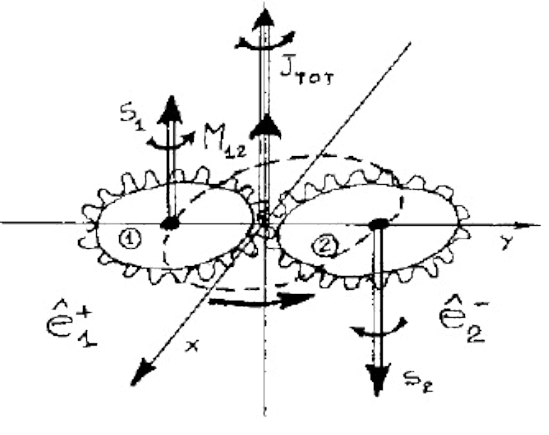
Figure 5: A reproduction of “gear model“ used in Section 5, page 852, Ref. [19] to illustrate the strongly attractive character of contact non-Hamiltonian forces when the constituents are in singlet coupling and their strongly repulsive character when in triplet